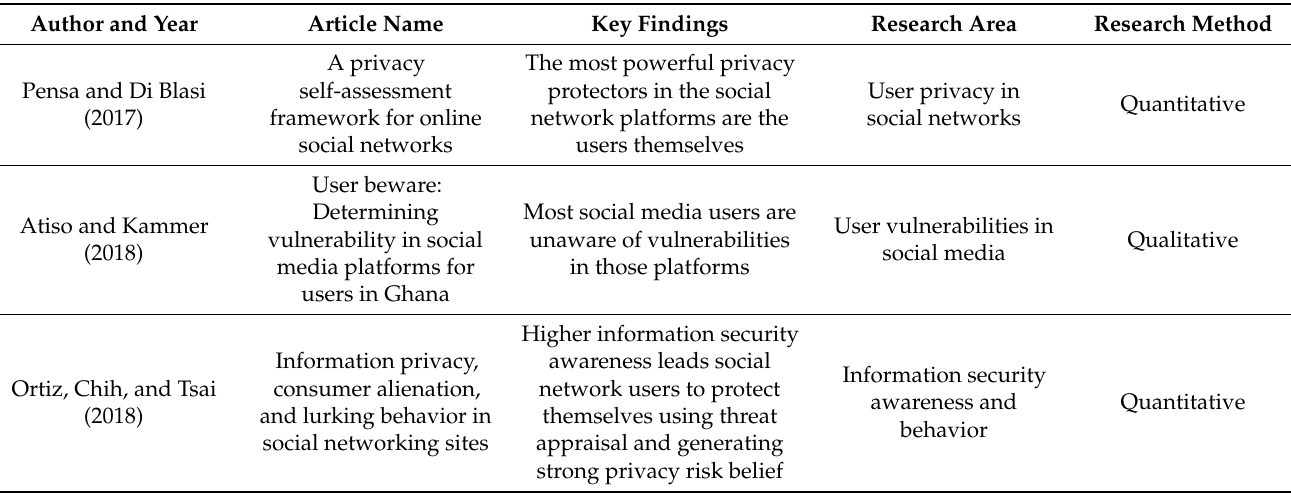
Table A7. User awareness when using social